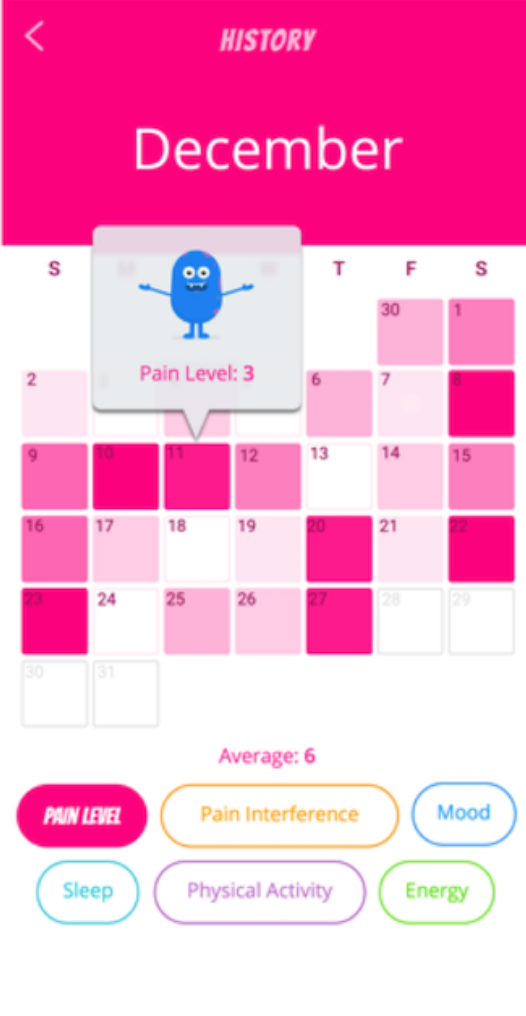
Figure 2. Example screenshot of the iCanCope History